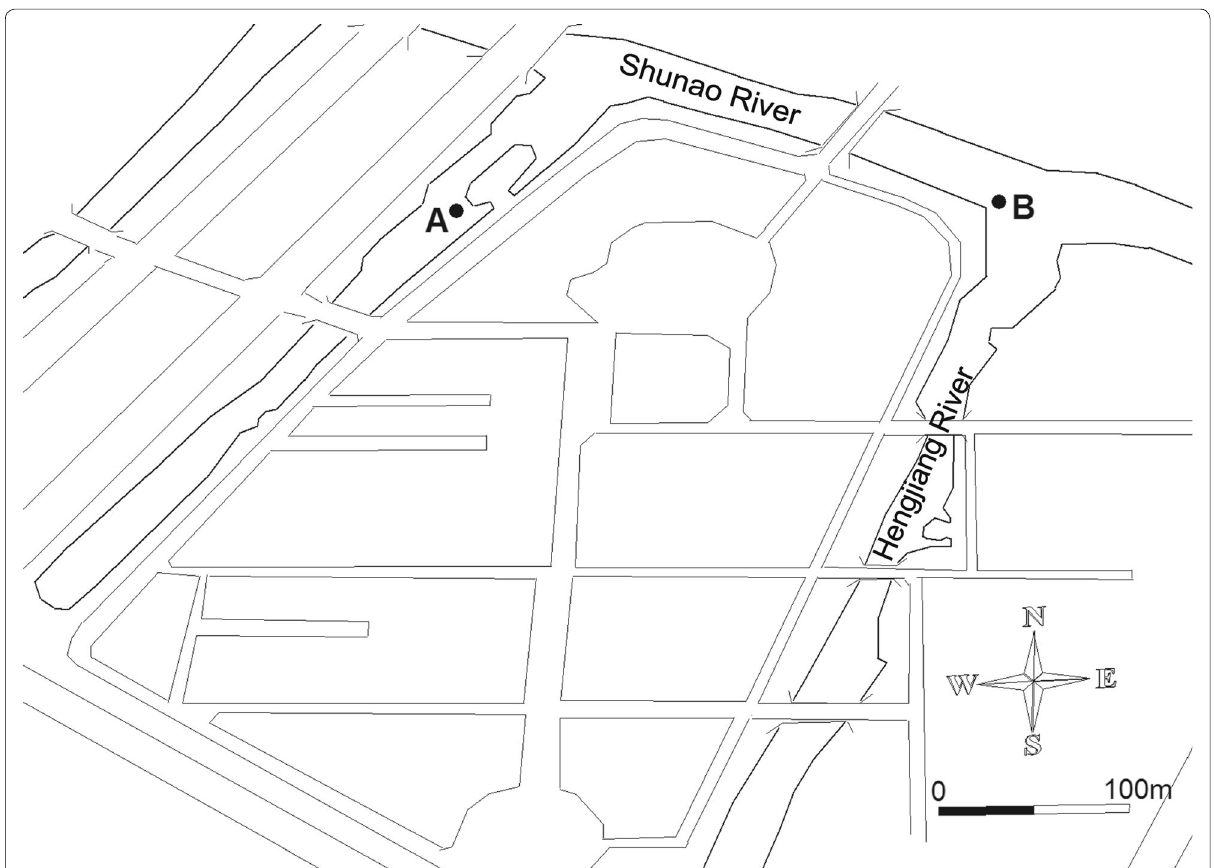
Fig. 1 Location of the study sites in Shunao River and Hengjiang River tributaries of the Wen-Rui Tang